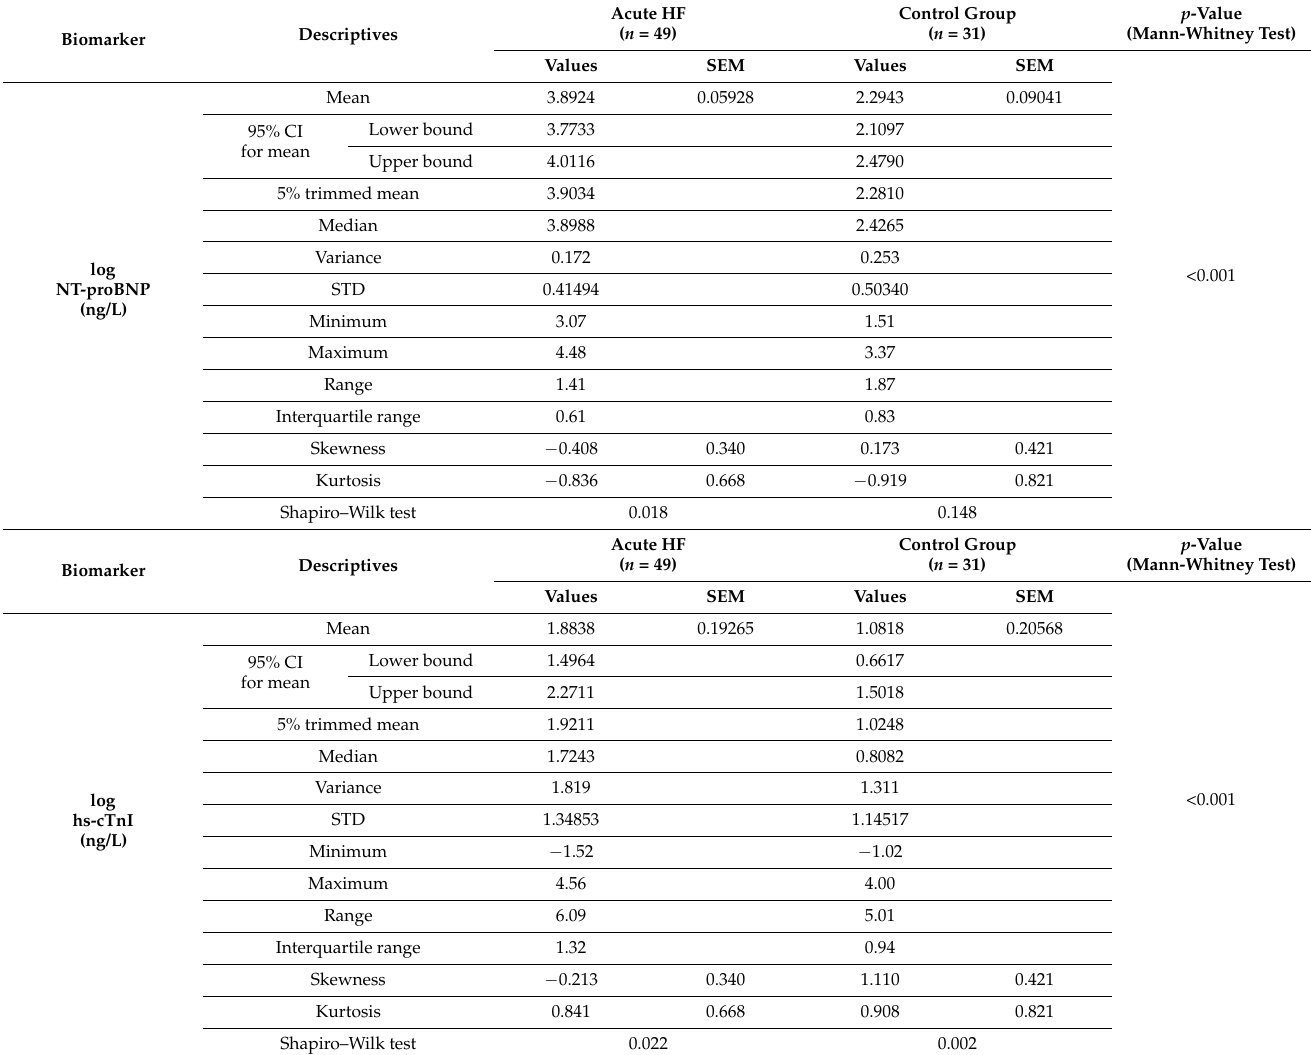
Table 7. Log-transformed cardiac biomarkers profile in acute HF and control